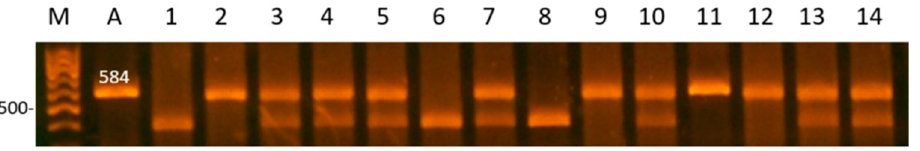
Figure 3. The Taq I polymorphism c.2851 G > T in gene SPEF2 : 2, 9, 11, 12—genotype TT (584 bp); 3–5, 7, 10, 13, 14—genotype GT (584, 460, 124 bp); 1, 6, 8—genotype GG (460, 124 bp); A—amplicon; M—marker.